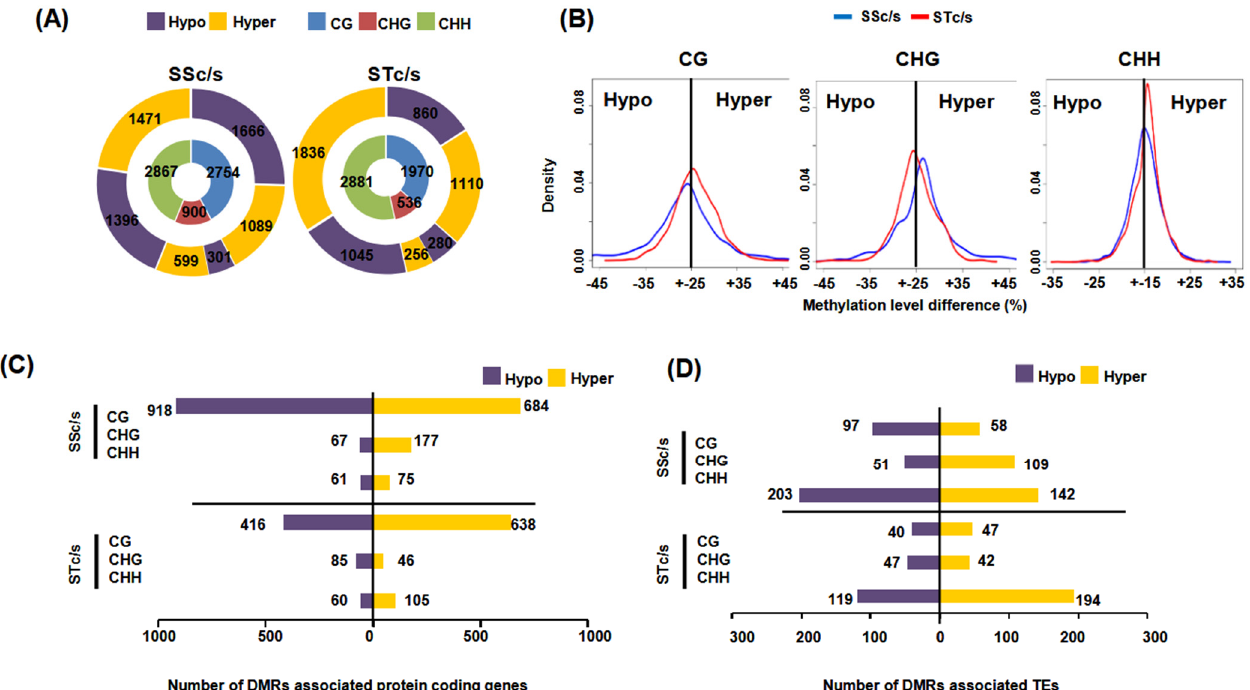
Figure 2. Identification and analysis of differentially methylated regions (DMRs). ( A ) Number of hypo and hypermethylated DMRs (outer circle) identified in different sequence contexts (CG, CHG, and CHH, inner circle) in the SS and ST genotypes under salinity stress. ( B ) Methylation level differences shown via kernel density plots in CG, CHG, and CHH sequence contexts. ( C ) Number of protein-coding genes associated with hypo and hypermethylated DMRs. ( D ) Number of TEs associated with hypo and hypermethylated DMRs. SSc/s and STc/s represent a comparison of salinity stress with control samples of SS and ST genotype, respectively.